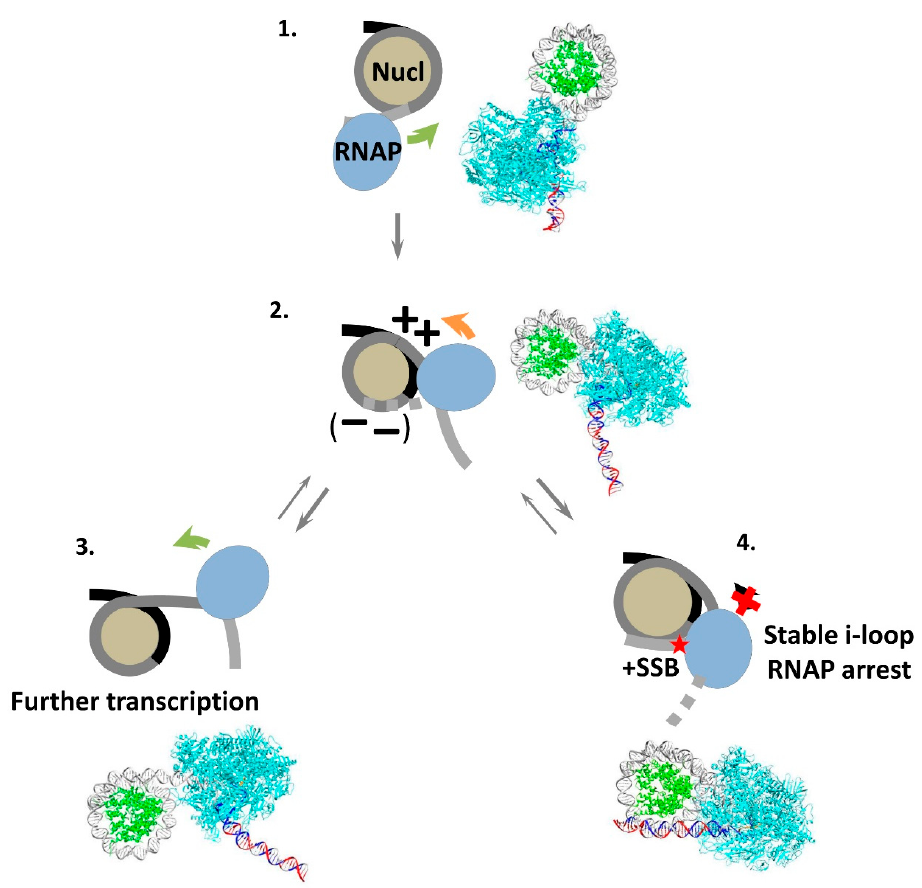
Figure 7. The mechanism of i-loop formation and arrest of RNA polymerase. As RNAP enters a nucleosome (intermediate ( 1 )), it partially uncoils nucleosomal DNA from the histone octamer (intermediate ( 2 )). Transcription through a nucleosome by Pol II can be accompanied by the formation of transient, small intranucleosomal DNA loops (i-loops) containing the enzyme (intermediate ( 2 )) at several locations of the enzyme [45]. Formation of the i-loop could be accompanied by accumulation of negative (–) and positive unconstrained DNA supercoiling (++) behind and in front of the enzyme, respectively. The loops must be opened either in front or behind Pol II to allow for the rotation of the enzyme and further transcription accompanied by nucleosome recovery (intermediates ( 2 ) and ( 3 )). Alternatively, when a single-stranded DNA break is present behind the enzyme in non-template DNA strand, the loop is formed more efficiently, causing the arrest of transcribing Pol II within the i-loop (intermediate ( 4 )). Thus, i-loops can serve as sensors of DNA breaks present in non-template DNA strand and hidden in the chromatin structure.